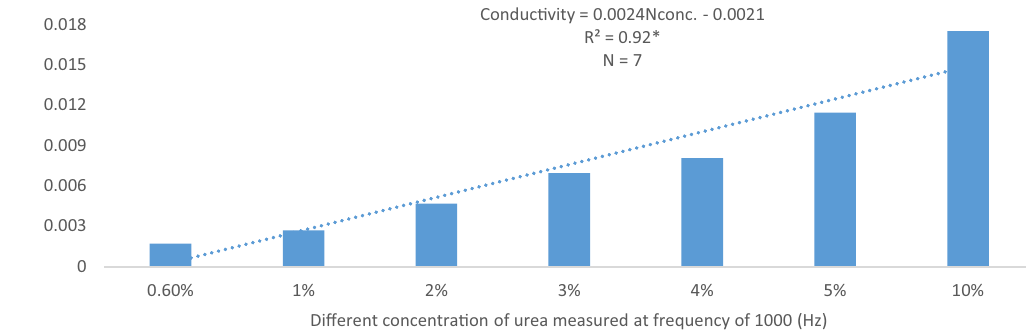
Figure 10. Conductivity of N solution (0.6%, 0.8%, 1.0%, 2.0%, 3.0%, 4.0%, 5.0%, and 10.0%) within 0.01 Hz and 100 kHz.